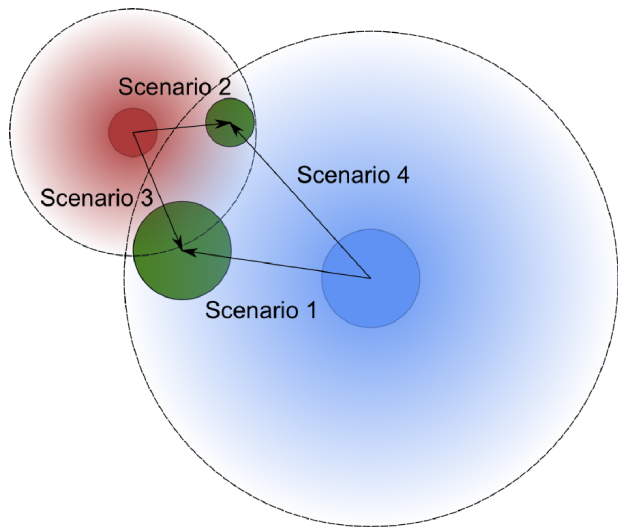
Figure 2. Description of the four different scenarios of particle